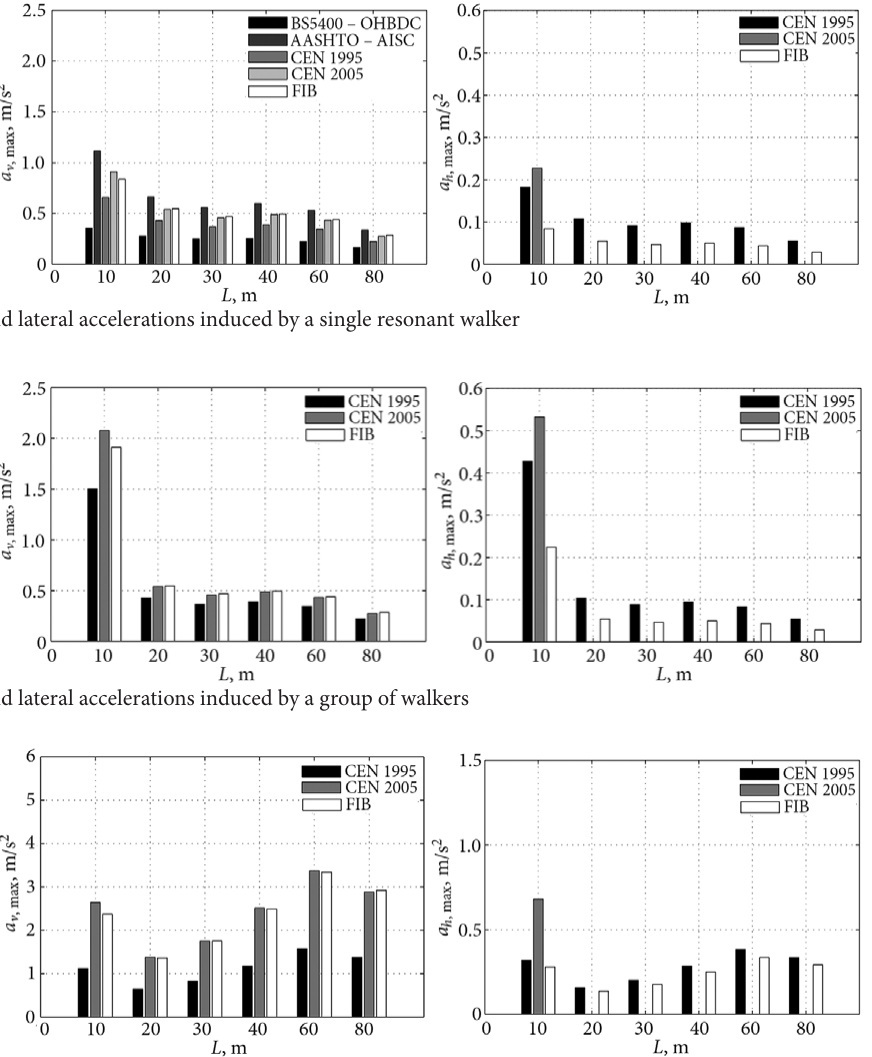
Fig. 13 . Vertical and lateral accelerations induced by a flow of 0.6 walkers/m Table 4. Vibration frequency variation due to the mass of the walkers (footbridges with concrete slab)